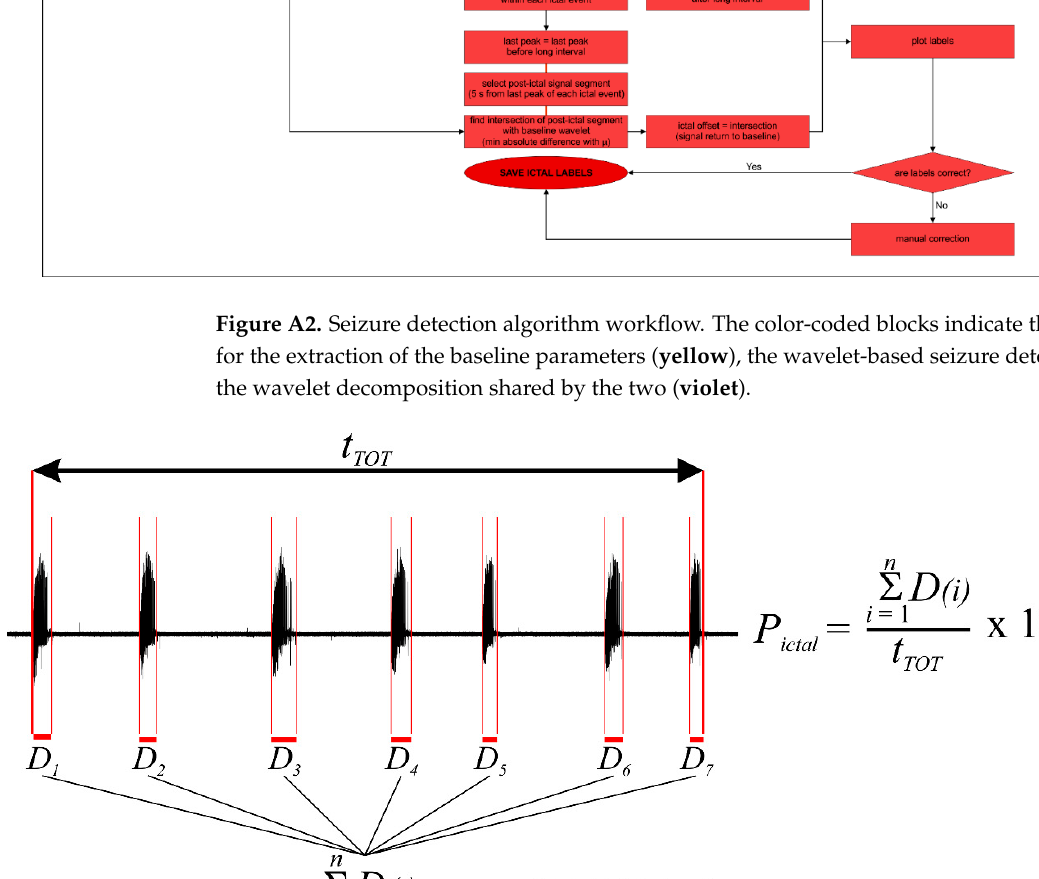
Figure A3. Method for the computation of t TOT and P ictal . Representative CTRL recording including seven ictal discharges ( D 1–7 ). The onset and termination of each ictal event are marked by the vertical red lines. The start and end of the observation window ( t TOT ) are marked by the higher thick red lines and indicated by the horizontal double-arrowed line. The duration of each measured ictal event (horizontal red line below the corresponding D 1–7 event) is summed to obtain the total time spent in the ictal state. This is then normalized against the t TOT and multiplied by 100 to obtain the percentage value ( P ictal ).